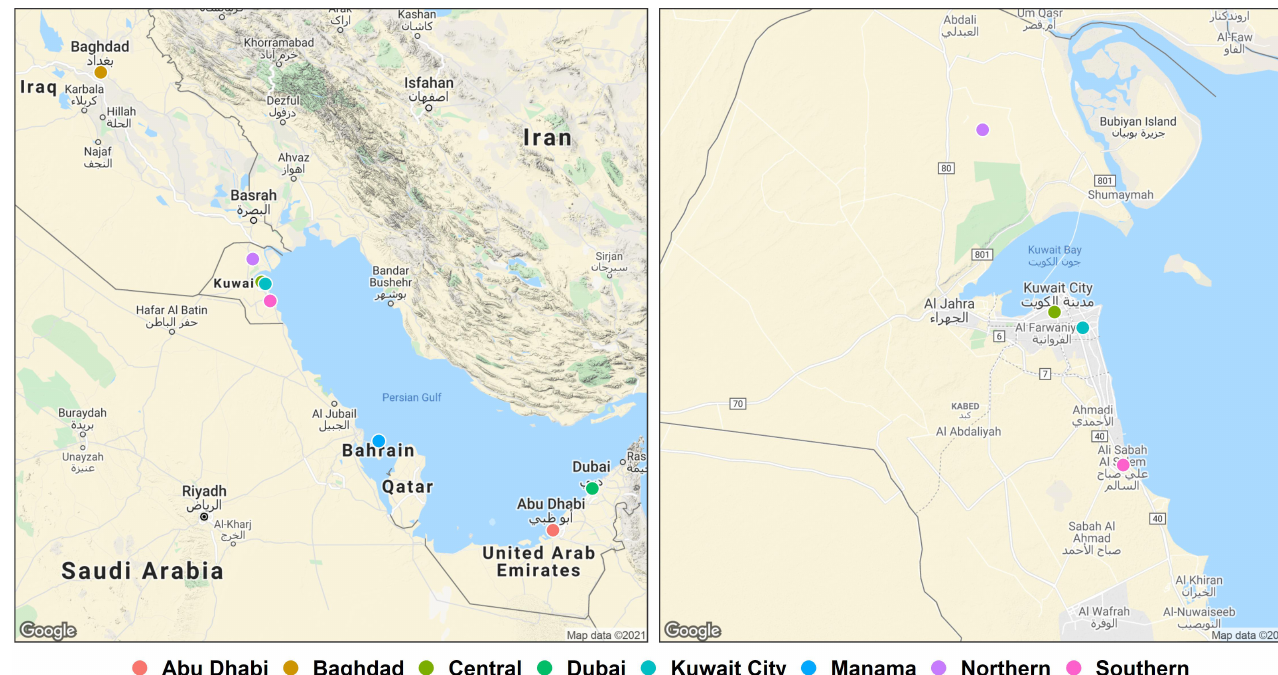
Figure 1. Map of the study region with all PM 2.5 monitors ( left ) and only those in Kuwait ( right